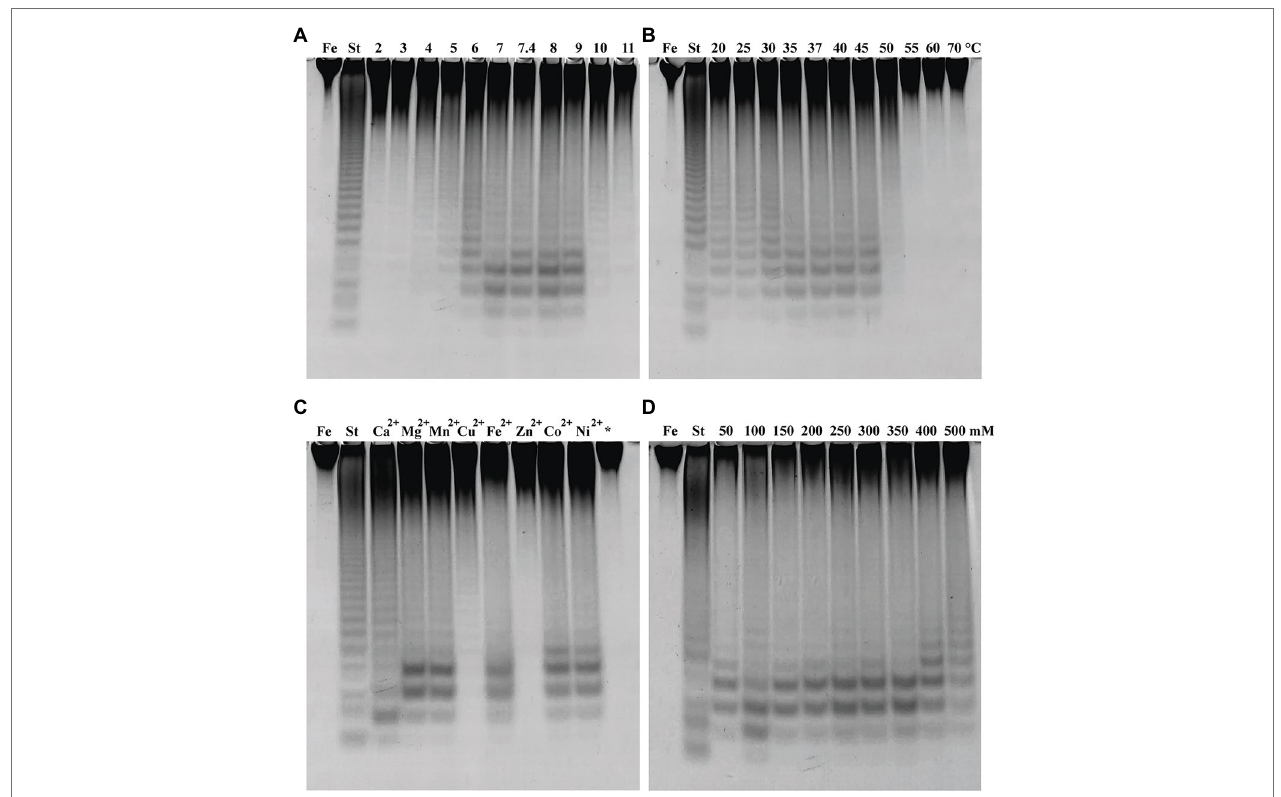
FIGURE 6 | Fhf2 ∆ 484 activity under different reaction conditions shown by C-PAGE. Activity of Fhf2 ∆ 484 on fucoidan from F. evanescens (FeF2) under the influence of different (A) pH (at 35 ° C), (B) temperature (at pH 8), (C) divalent cations at 10 mM (pH 8 and 37 ° C), (*) indicates the activity after addition of EDTA, e.g., without presence of any divalent cations, and (D) NaCl concentration dependency (at pH 8 and 37 ° C). (St) positive control reaction of FFA2 on F. evanescens fucoidan. General reaction conditions were 0.9% substrate, 0.3 mg/ml enzyme, 10 mM Tris-HCl and 4 h reaction